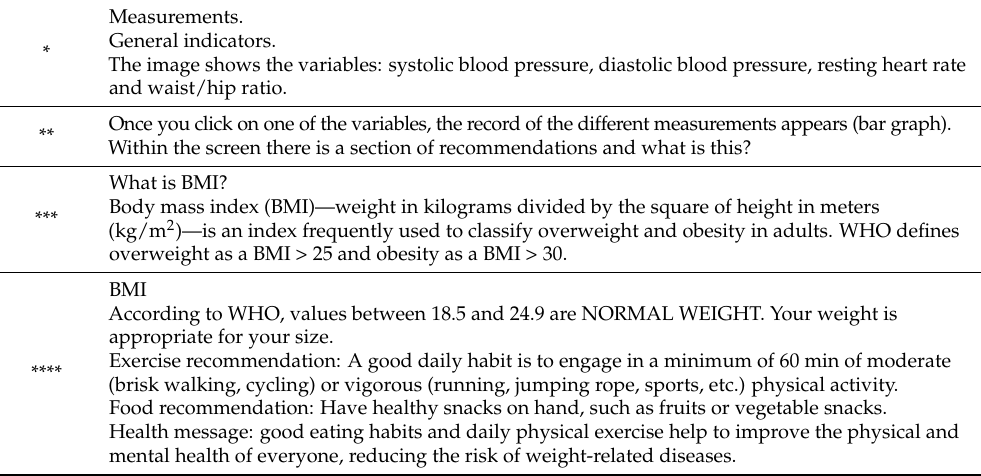
Figure 2. Actual representation of the mobile app used. Table 1. Information contained in the images of Figure 2 in